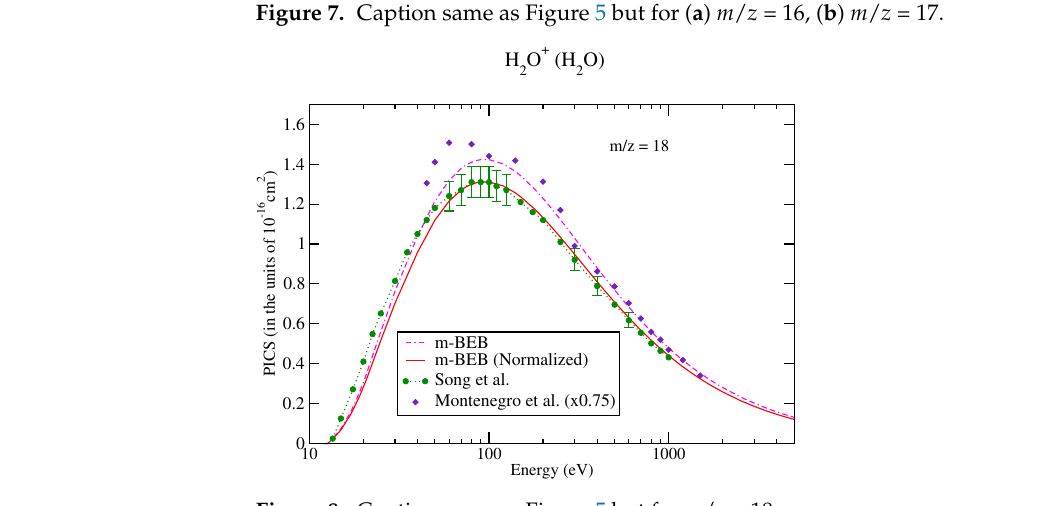
Figure 7. Caption same as Figure 5 but for ( a ) m / z = 16, ( b ) m / z = 17.